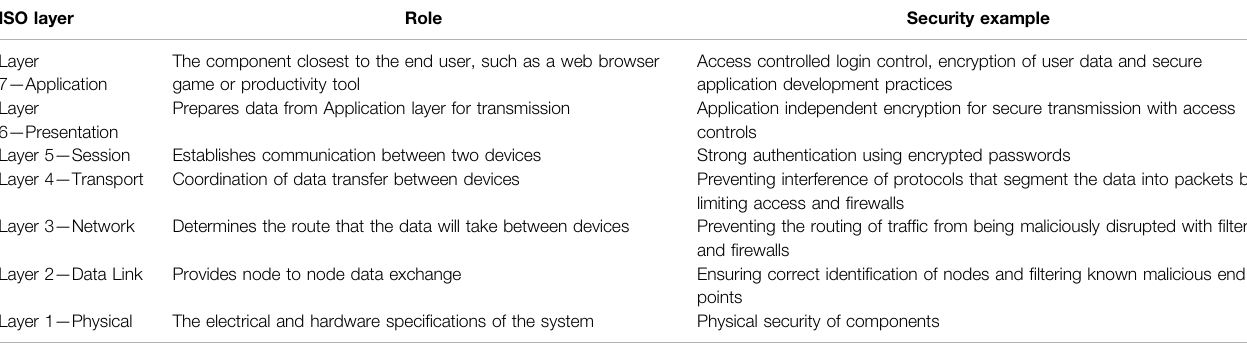
TABLE 1 | Comparison of data transmission